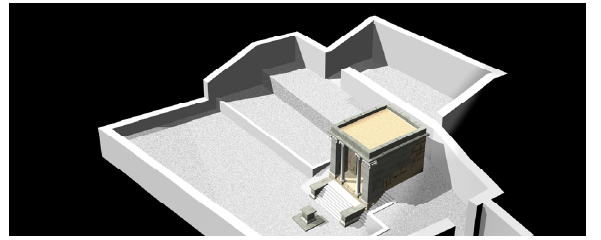
Figure 13. The architectural 3D model of the